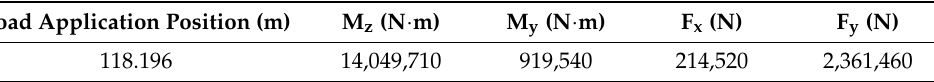
Table 1. Effect of the wind turbine on the tower.